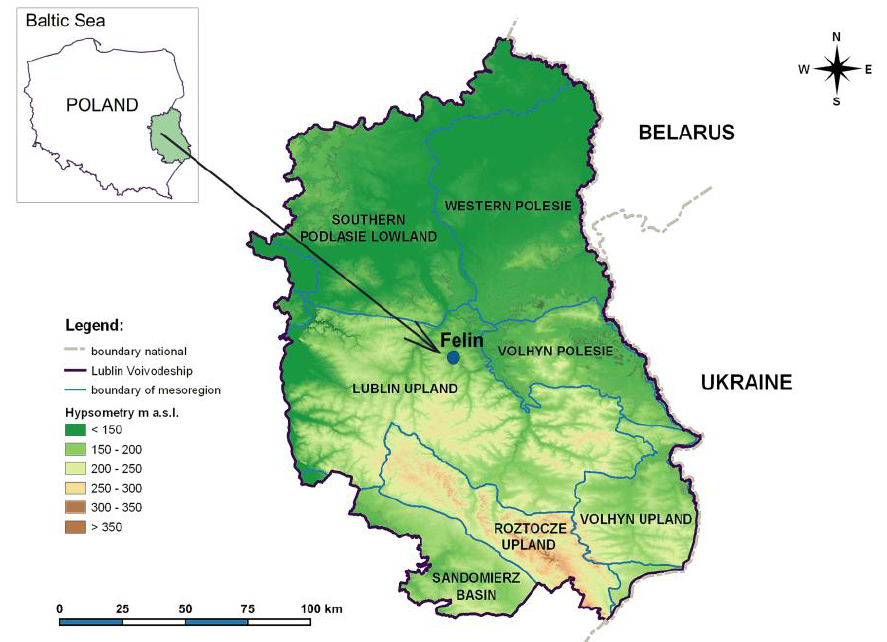
Figure 1. Localisation of Felin Experimental